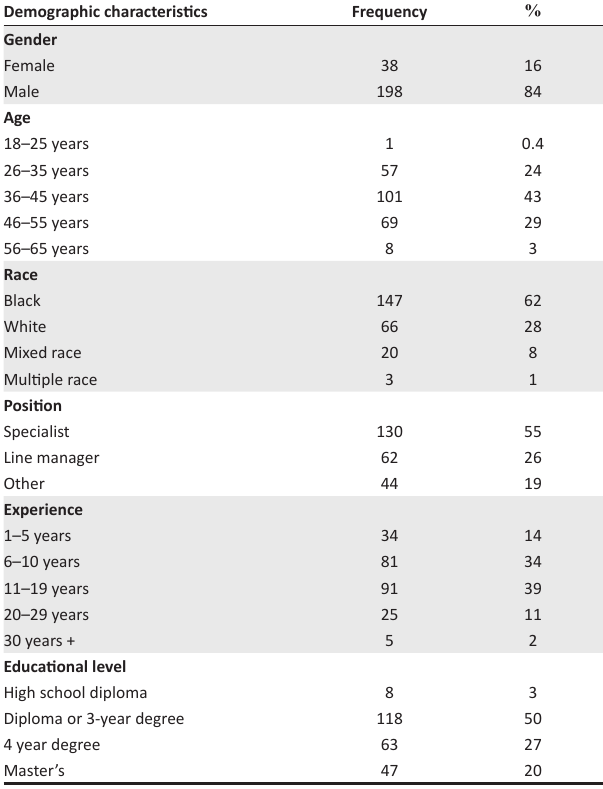
TABLE 2: Demographic profile of respondents ( n =